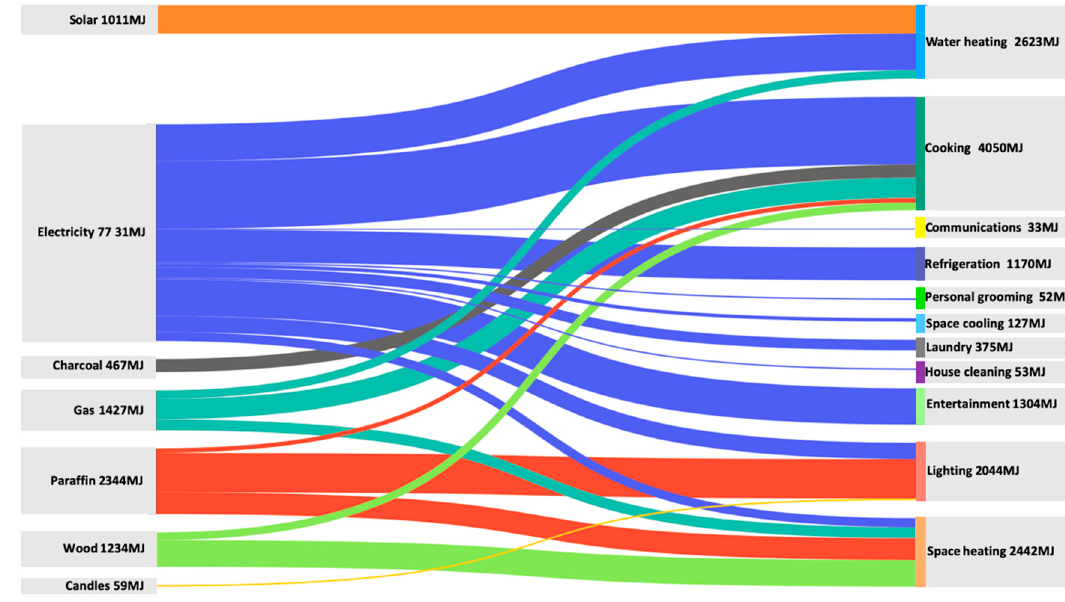
Figure 8. Average energy flows for low-income households in Cape Town. Source: Strydom et al. [58].